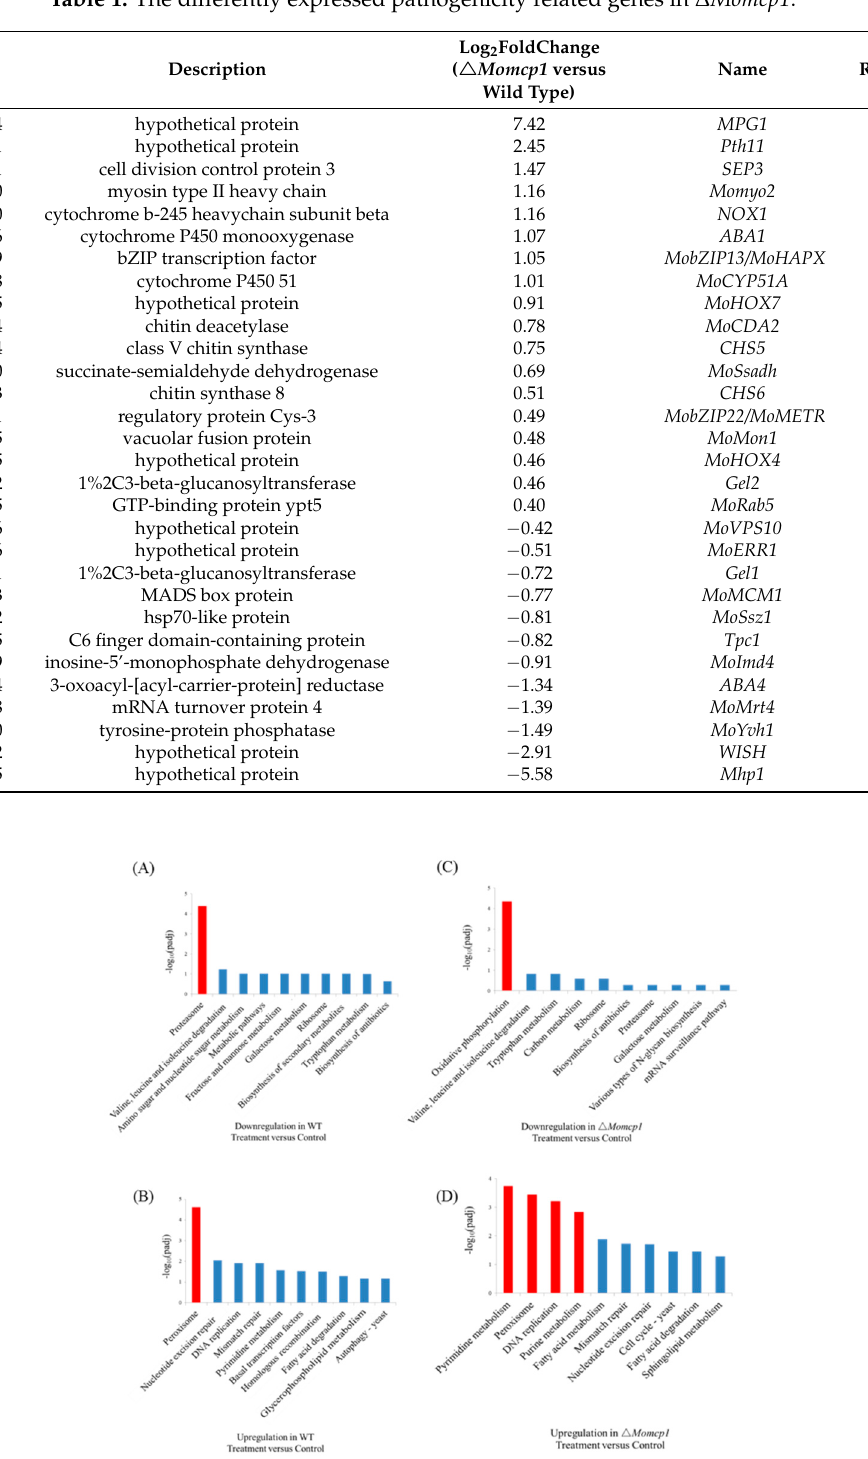
Table 1. The differently expressed pathogenicity related genes in ∆ Momcp1 .